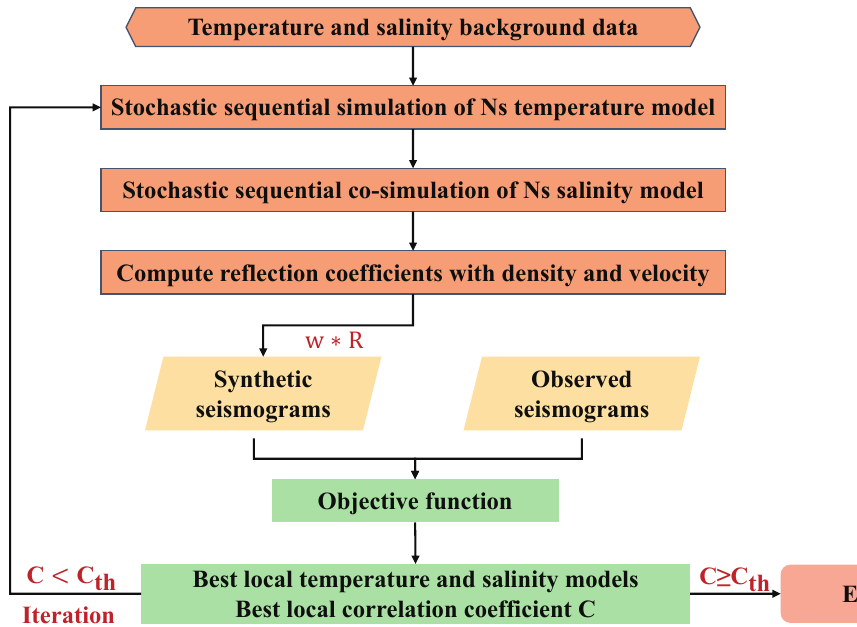
Figure 10. Typical workflow of the geostatistical seismic inversion method, C represents the global coefficient between the real and synthetic seismic data and C th is the threshold of the global coefficient. Adapted with permission from Refs. [87,89]. Copyright (2022), with permission from Springer and